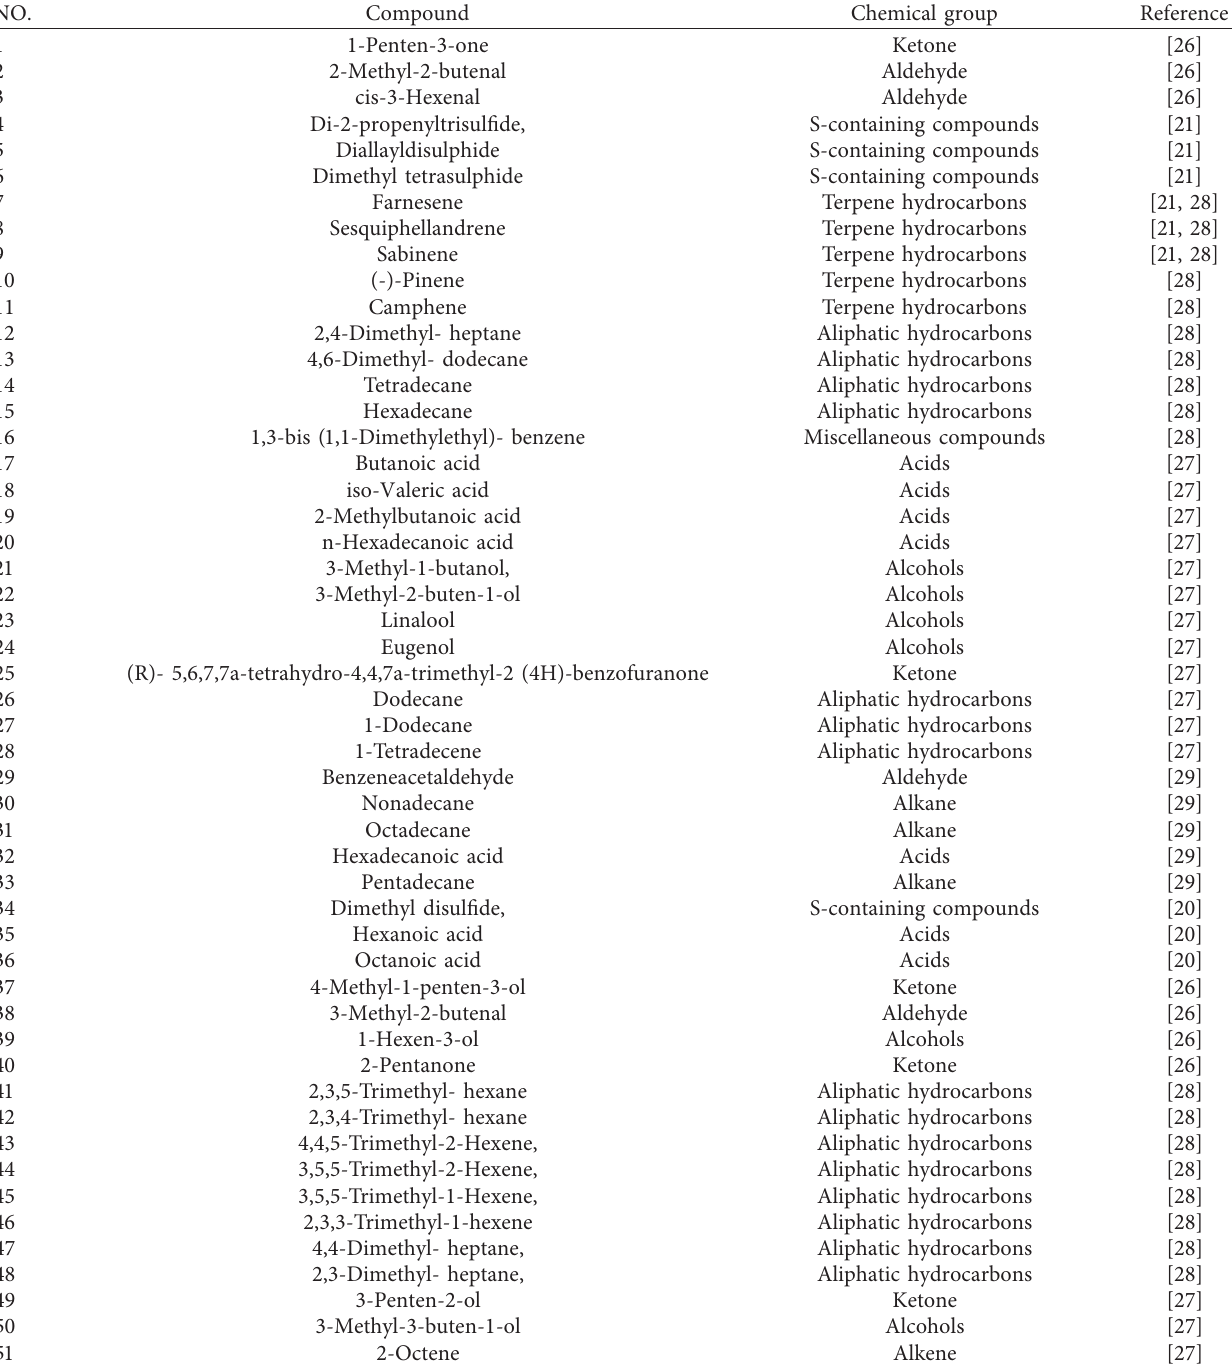
Table 2: Classified